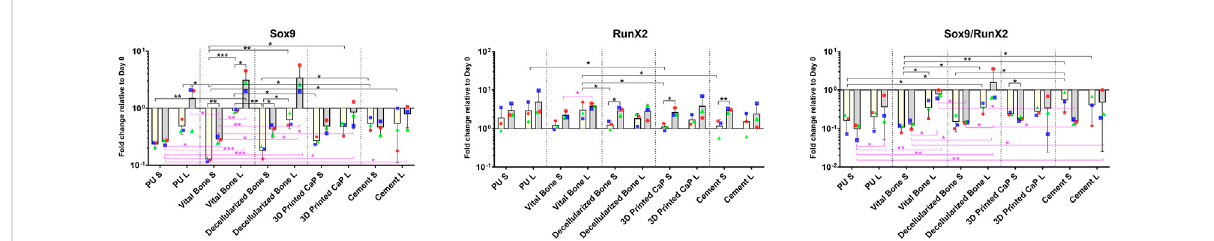
FIGURE 2 Gene expression of transcription factors SOX9 and RUNX2 in various scaffold systems under static (S) and loaded (L) conditions. Load generally led to an increase in both transcription factors. The load induced increase in SOX9 was most pronounced in the PU, vital bone, and bone dead groups. When considering the SOX9/RUNX2 ratio, the higher values were observed in the loaded groups with the bony bases. * p < 0.05, ** p < 0.01, *** p < 0.001. Black signi fi cance bars designate differences on Day 7 among all groups or day 7 vs. day 28 within the same group. Purple signi fi cance bars designate differences on Day 28.